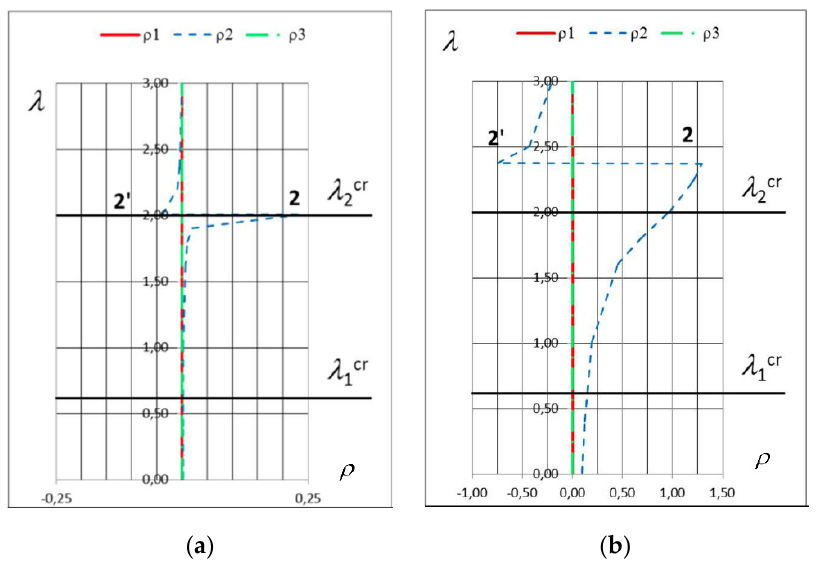
Figure 13. Coefficient ρ for geometrical imperfections developed according to the second buckling mode: ( a ) small ( m 2), ( b ) large ( d 2).